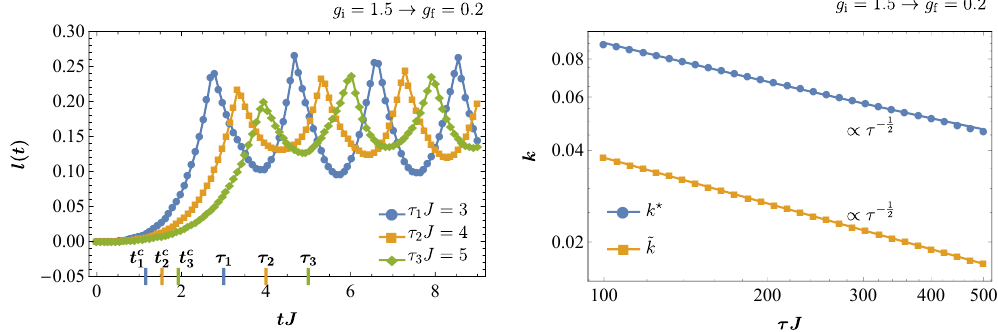
< τ . On the occurs during quench, ie, t (cid:63) 1 1 as well as the times t c at which the critical i i ( k (cid:63) ) = 0 and n